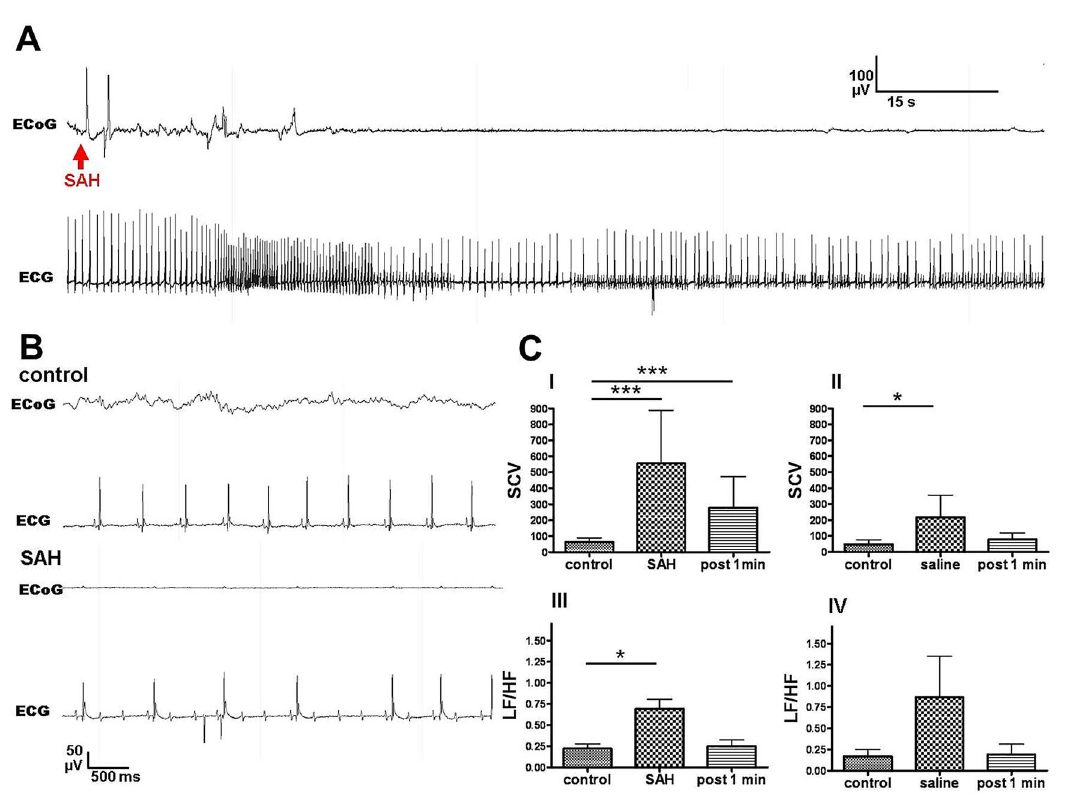
Fig. 6. Cardiac responses to SAH induction. Fig. 6 depicts a sample ECG trace after SAH. Three out of seven mice in the SAH group displayed transient high grade second and/or third degree atrioventricular block during flat-lining of the ECoG shortly after SAH (Figs. A and B bottom). F-test for comparison of equality of variances revealed increased SCV in SAH mice (C I) and in saline-injected mice (C II). SAH mice also display a transient significant increase in LF/HF ratio, potentially reflecting sympathetic activation to stabilize CPP after SAH or a Cushing reflex due to elevated ICP (C